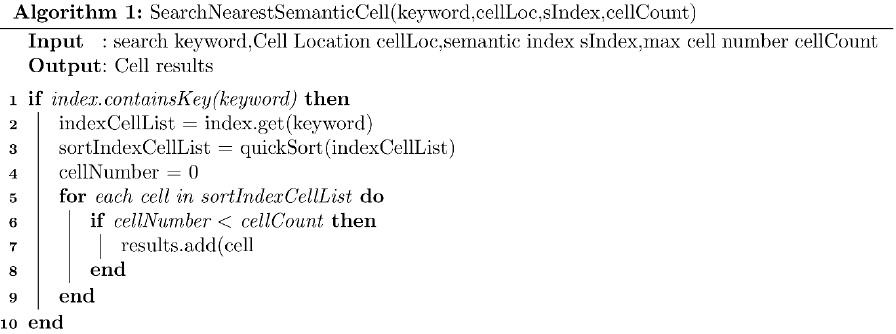
Figure 12. The algorithm for nearest semantic cell search.